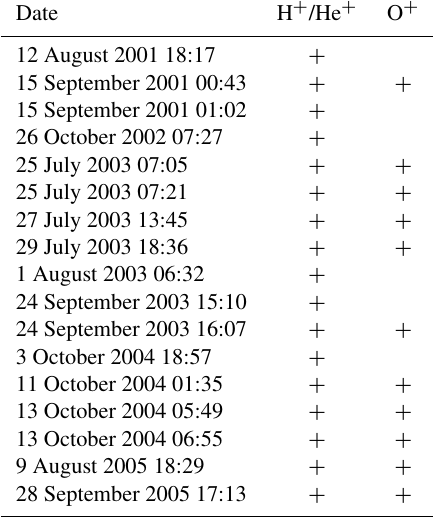
Table 1. The list of time moments of the dipolarization onset ob- served in the events from our database. “ + ” marks those events, in which the reliable fluxes of H + , He + and O + ions were detected by RAPID